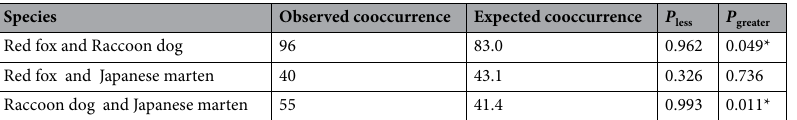
Table 1. Results of the probabilistic co-occurrence analysis. Observed cooccurrence is the number of observations in which two species cooccur during one night. Expected cooccurrence represents the expected frequency of two species co-occurring during one night. P less represents the probability that the two species would co-occur at a frequency smaller than the observed frequency, if the two species had occurred randomly (independently). P greater represents the probability that the two species would co-occur at a frequency greater than the observed frequency, if the two species had occurred randomly (independently). The number of presence of data was 479 for red foxes, 460 for raccoon dogs, and 239 for Japanese martens. Asterisk represents P < 0.05.